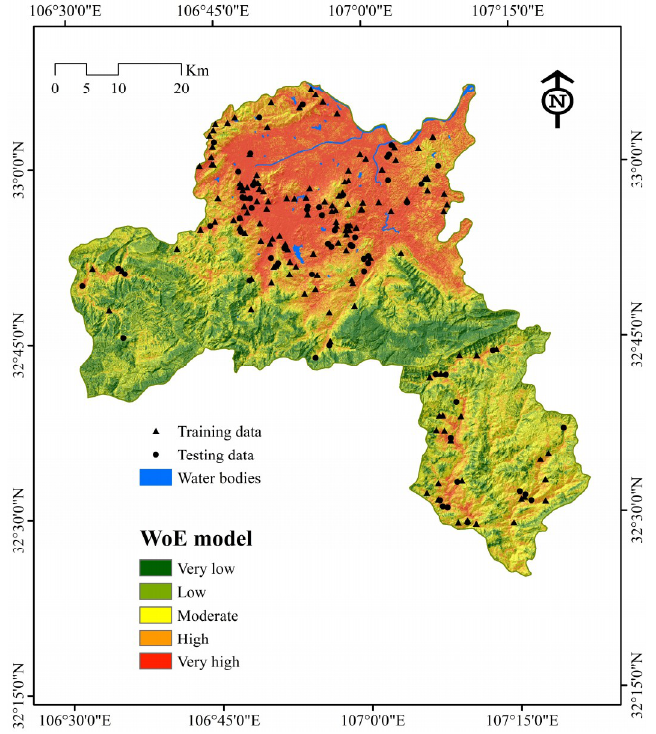
Figure 4. Landslide susceptibility map using the WoE